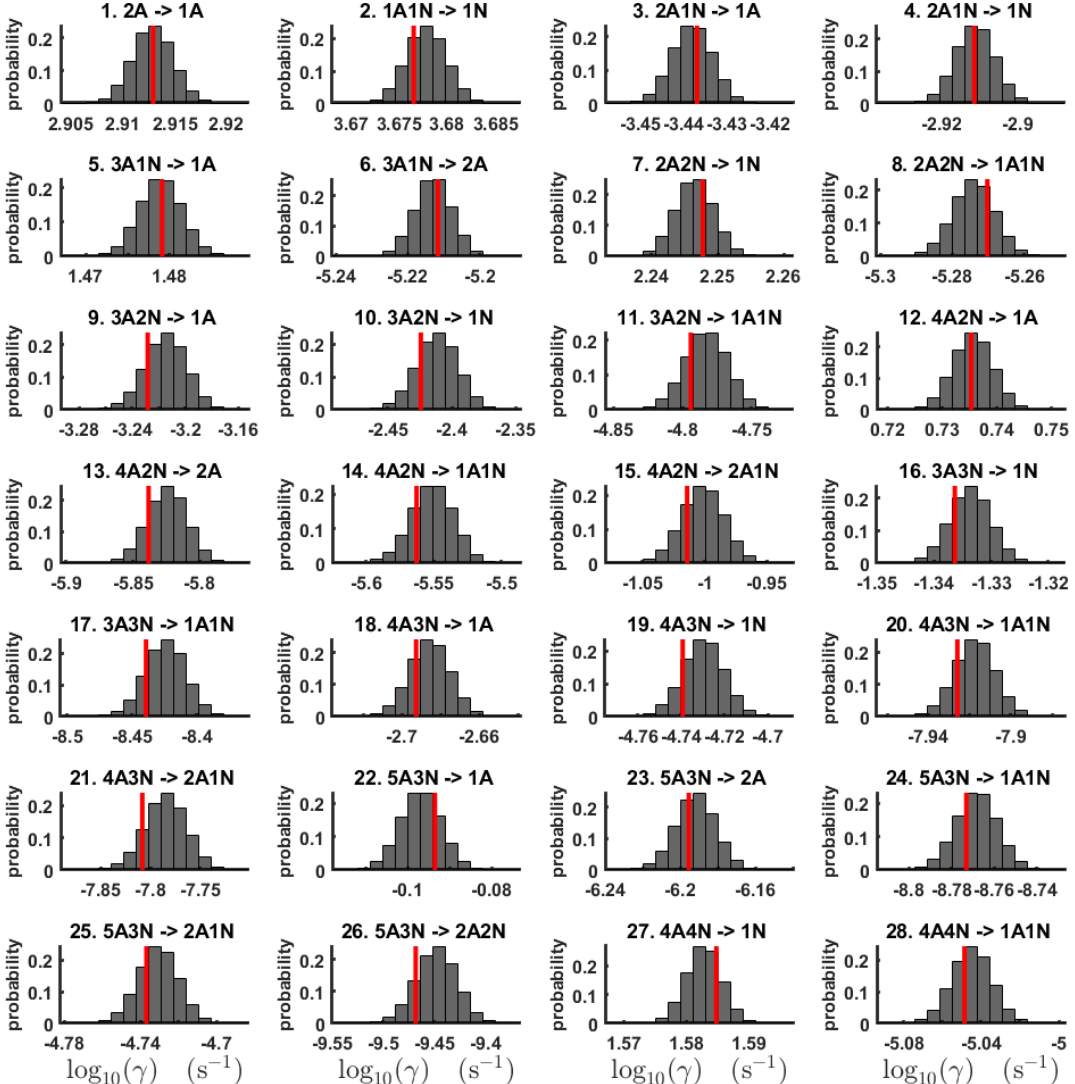
Figure D6. One-dimensional marginal distributions (for parameter indexes ranging from 1 to 28) of the base 10 logarithm of the evaporation rates (units given in s − 1 ) at temperature 278K obtained from a posterior distribution of thermodynamic parameters (cluster formation enthalpies and entropies) determined from steady-state cluster concentration measured at temperatures 278 and 292K. Red lines denote the baseline values from Olenius et al. (2013b) used to generate the synthetic data. The notation xAyN corresponds to a cluster with x sulfuric acid and y ammonia